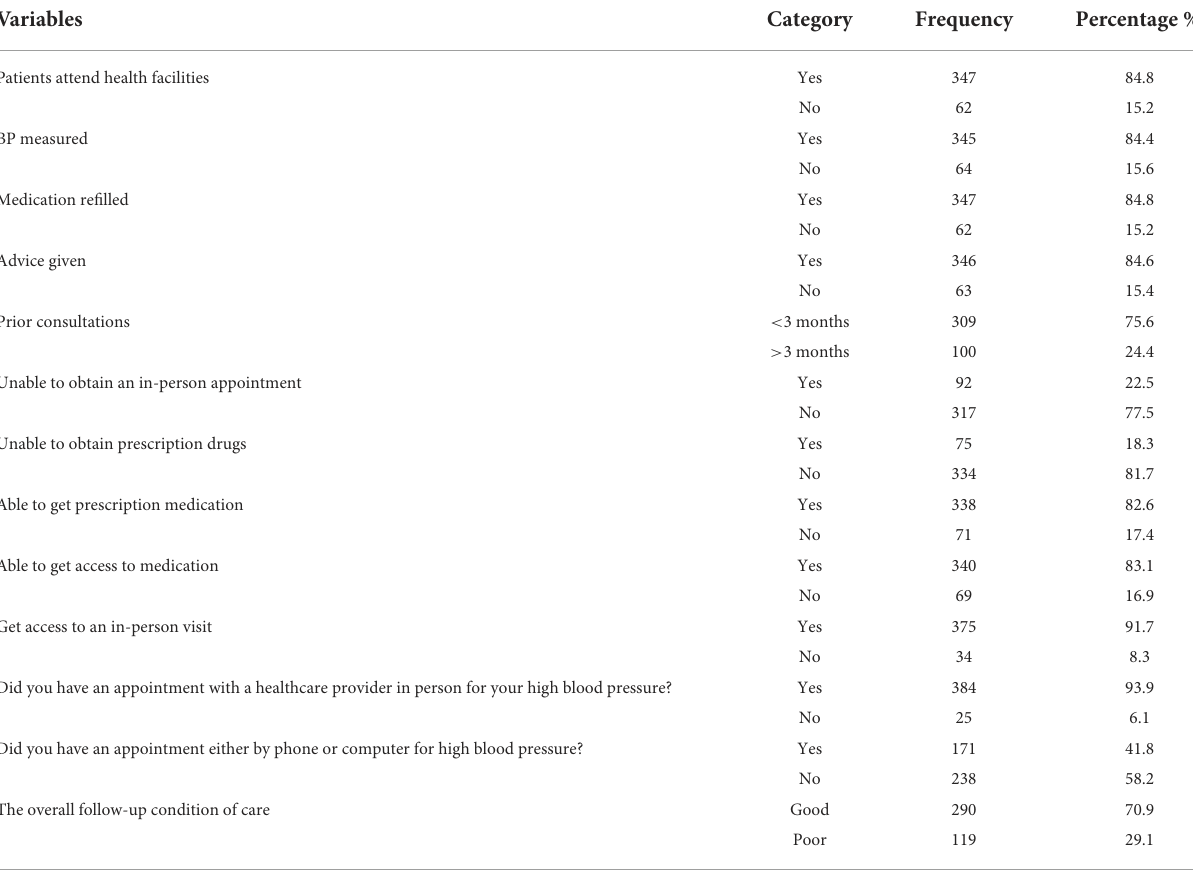
TABLE 2 Follow-up condition of care among adult hypertensive patients at West Arsi public health facilities during COVID-19, Ethiopia, 2021 ( N =